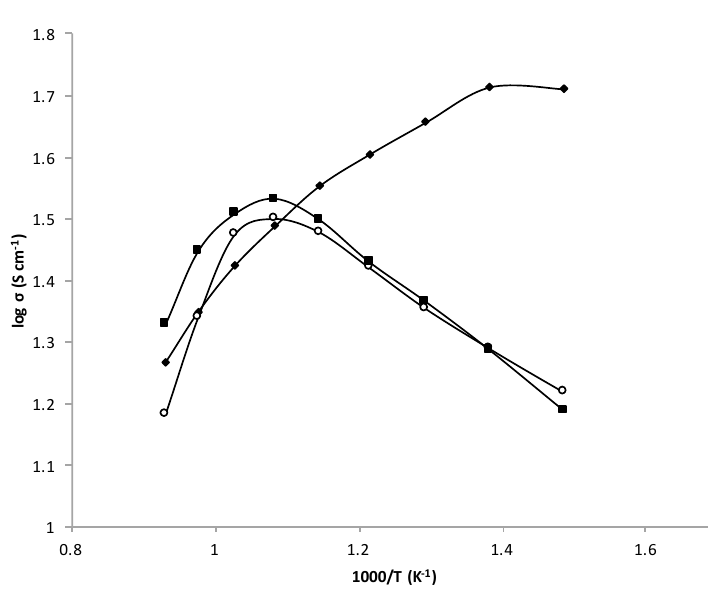
Figure 13. Plot of log σ vs. 1000/T for SrFeO 3- δ ( ● ), SrFe 0.95 B 0.05 O 3- δ ( ○ ), SrFe 0.9 B 0.1 O 3- δ ( ■ ) in air. Conductivity values (at 700 °C) for the borate- and sulfate-doped samples are shown in Table 5, and compared to the equivalent data for silicate-doped SrFeO 3- δ (from reference [23]). The data show similar values for all samples at this typical solid oxide fuel cell operating temperature. Table 5. Conductivity data in air at 700 °C for SrFe 1 − x M x O 3- δ where M = Si [23], S and B. Si (x) S (x) B (x)